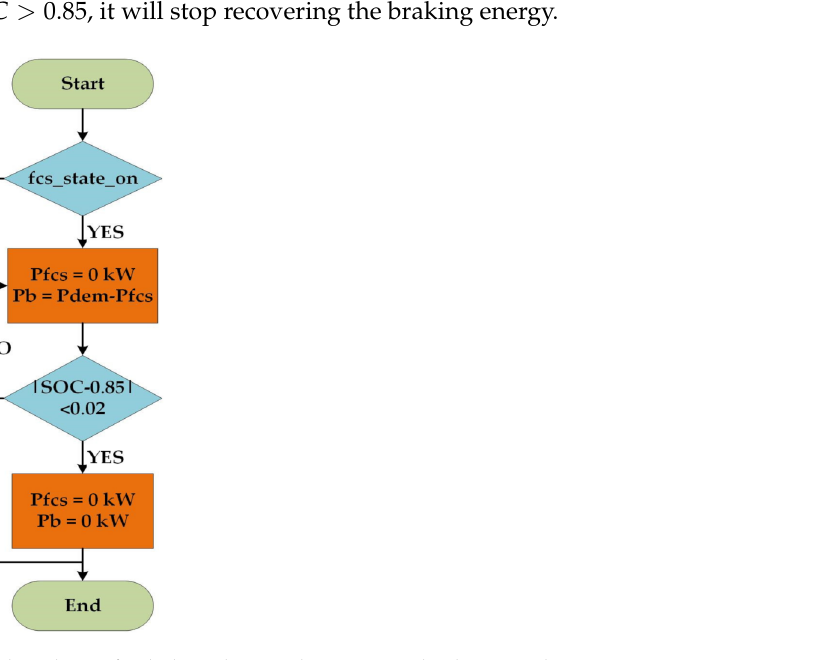
Figure 10. Flowchart of rule-based control strategy in braking